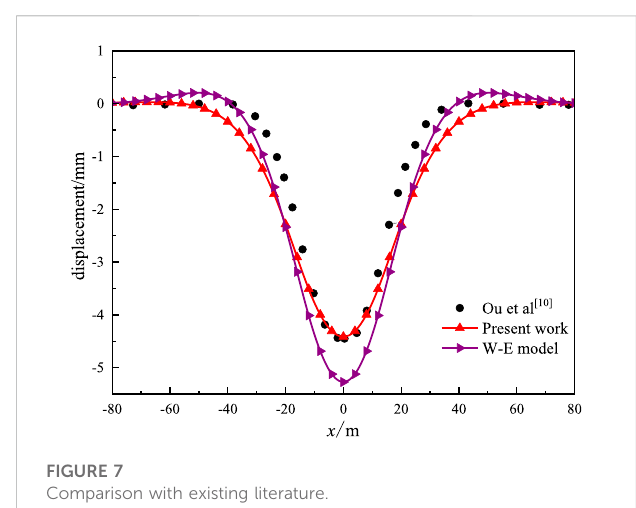
FIGURE 7 Comparison with existing